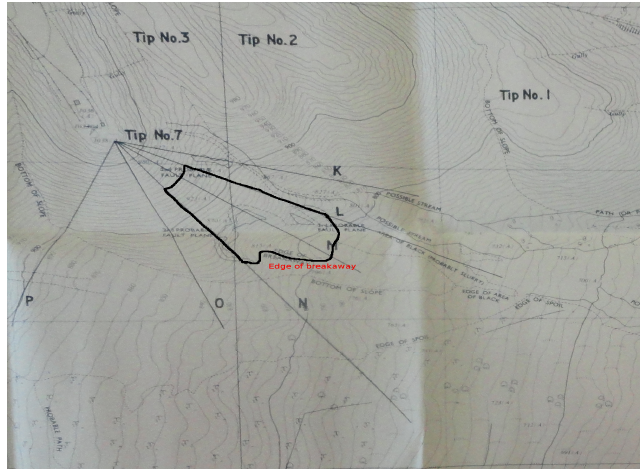
Figure 8. The edge of breakaway defined on Tip No. 7 (map from UK National Archive, Kew).